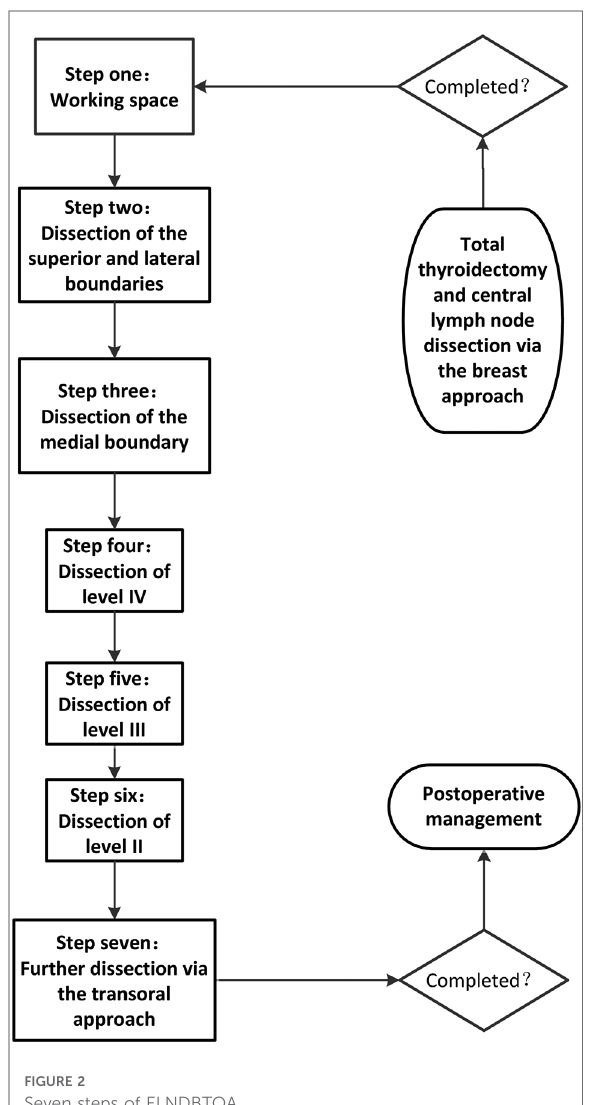
FIGURE 2 Seven steps of ELNDBTOA.